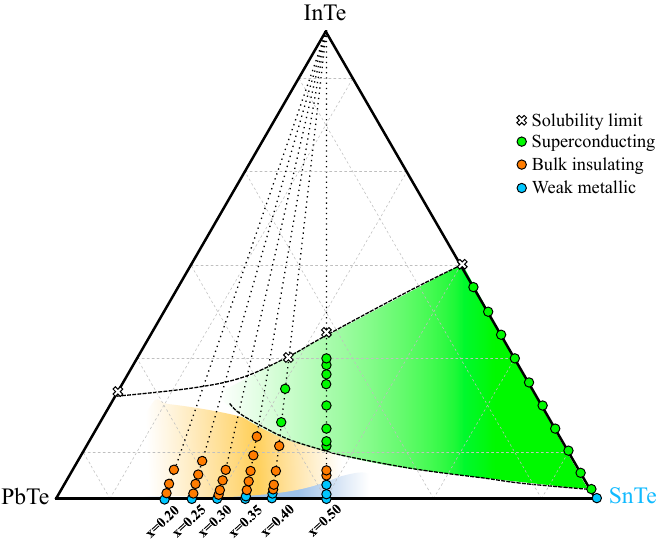
Figure 4. A ternary phase diagram summarizing all the resistivity behaviors of (Pb 1 − x Sn x ) 1 − y In y Te(PSIT). Experimental results for Sn 1 − x In x Te (SIT) with In content up to 10% is obtained from Reference [24]. The solubility limit of In in PbTe (24%) is obtained from Reference [51]. Samples with weak metallic resistivity are shown in blue, with insulating resistivity are shown in orange, and with superconductivity are shown in green. White crosses represent the solubility limit of In, beyond which the sample no longer remains in a single phase and secondary InTe phase shows